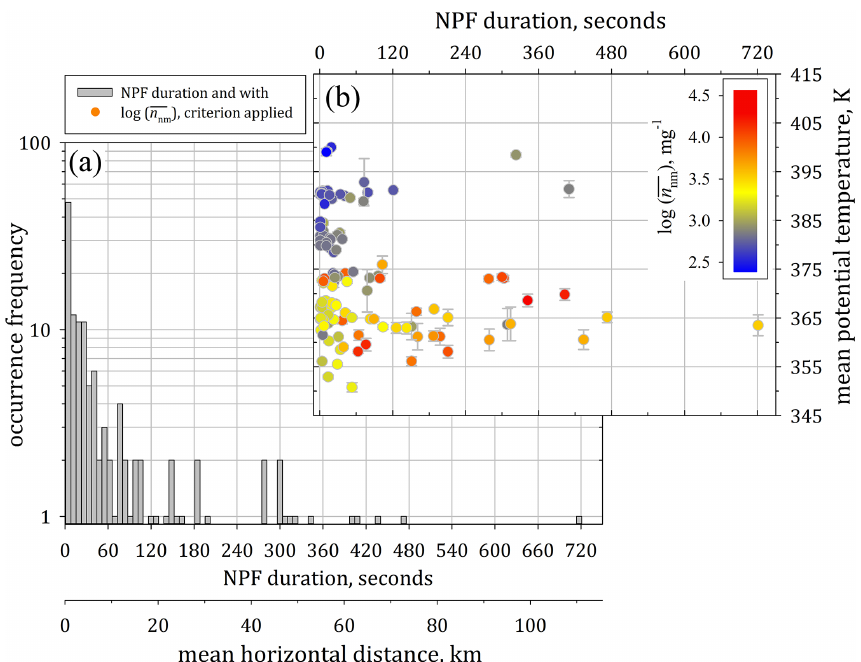
Figure 4. Frequency of the duration of observed NPF events during the StratoClim 2017 mission (a) as the frequency distribution of the NPF duration and (b) as a vertical profile as a function of mean potential temperature and coloured with reference to the mean mixing ratio n nm of the nucleation-mode